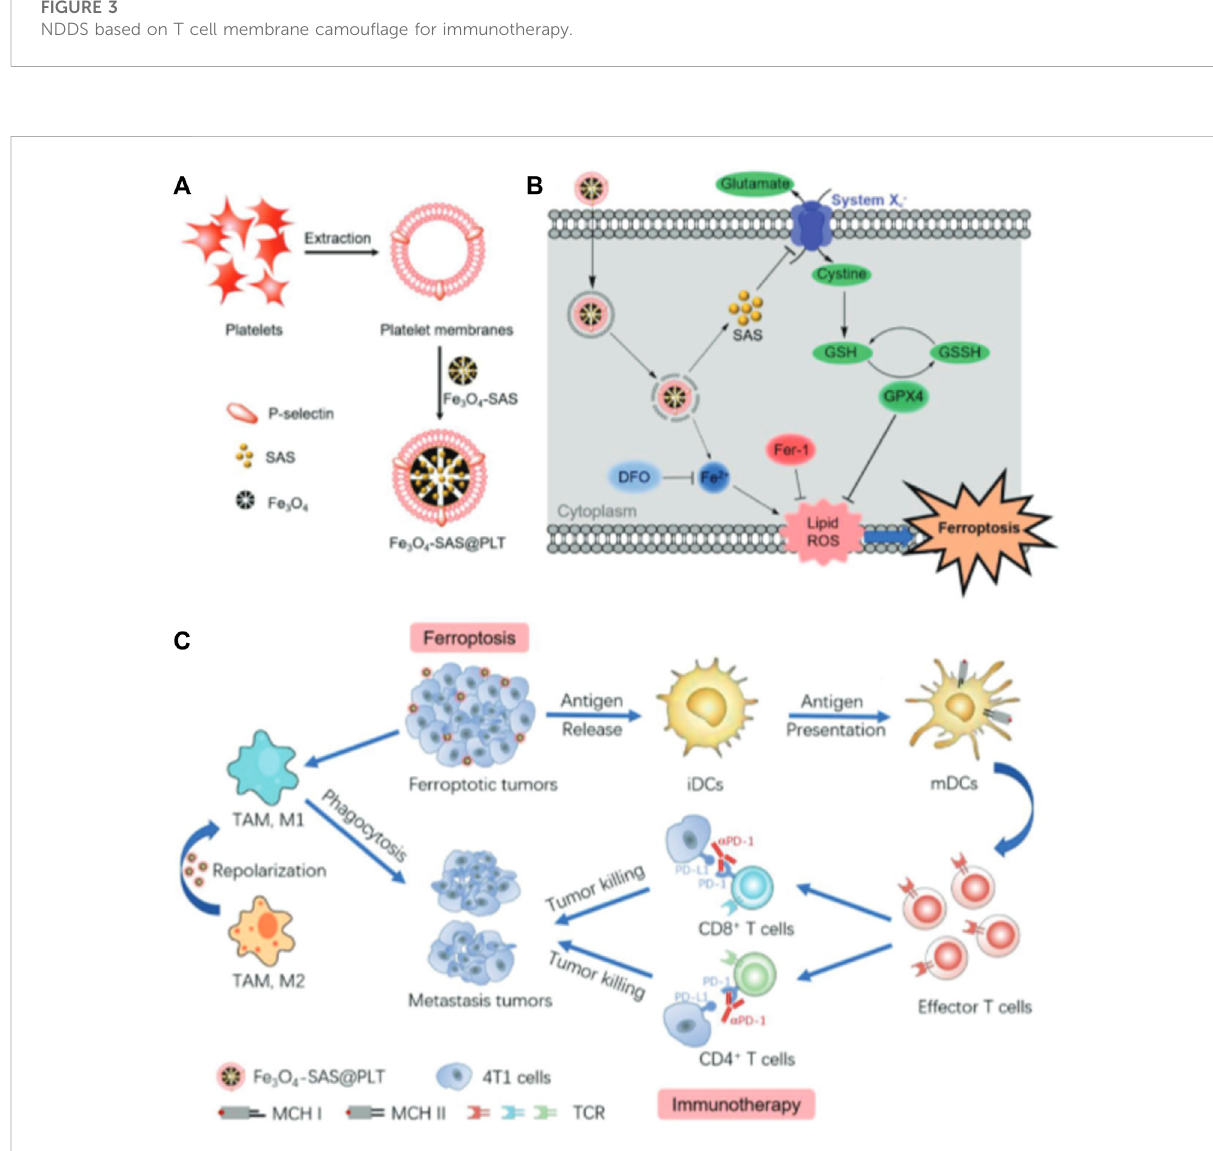
FIGURE 4 Magnetic nanoparticles coated with platelets for immunotherapy of iron-enriched cancer. Copyright Year 2020, Small (Jiang et al., 2020).